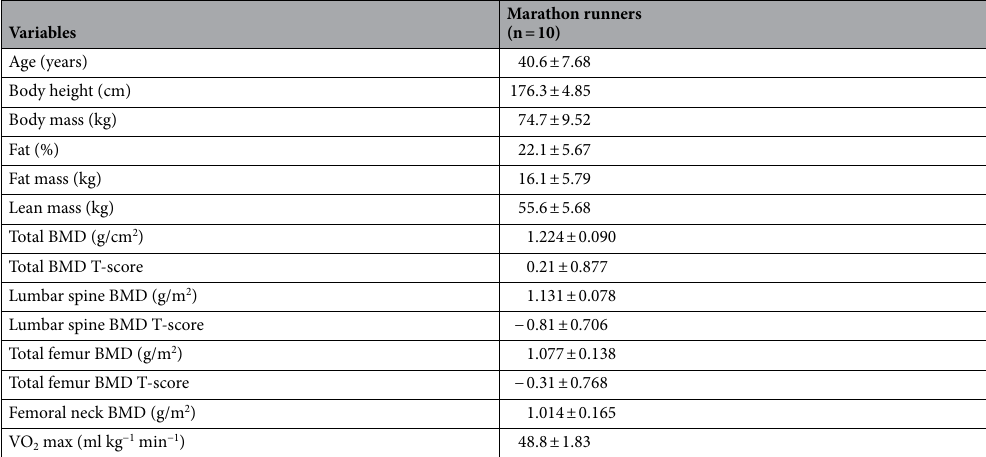
Table 2. Baseline characteristics of the study participants. Data are presented as mean ±